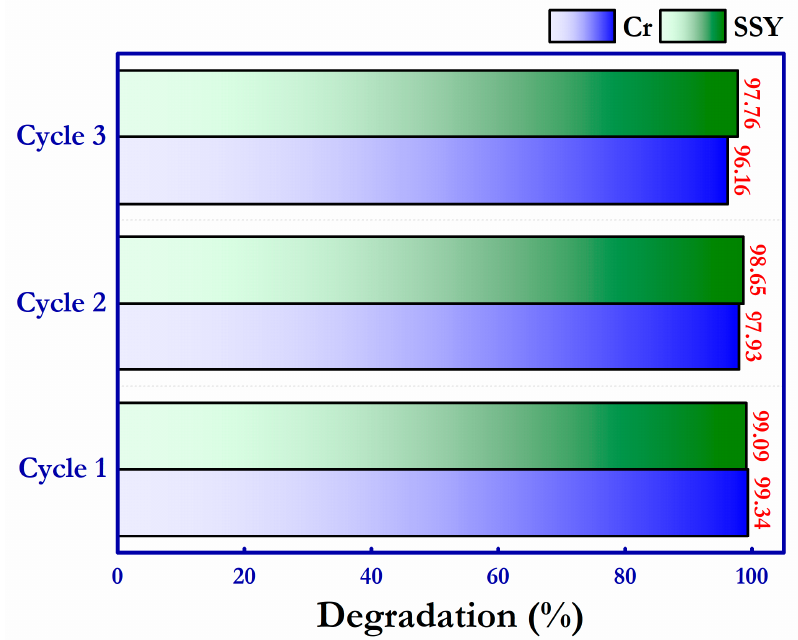
Figure 13. Recycling stability of the g-C 3 N 4 –SO 3 H photocatalyst towards the photoreduction of Cr (VI) and photooxidation of SSY under visible light.